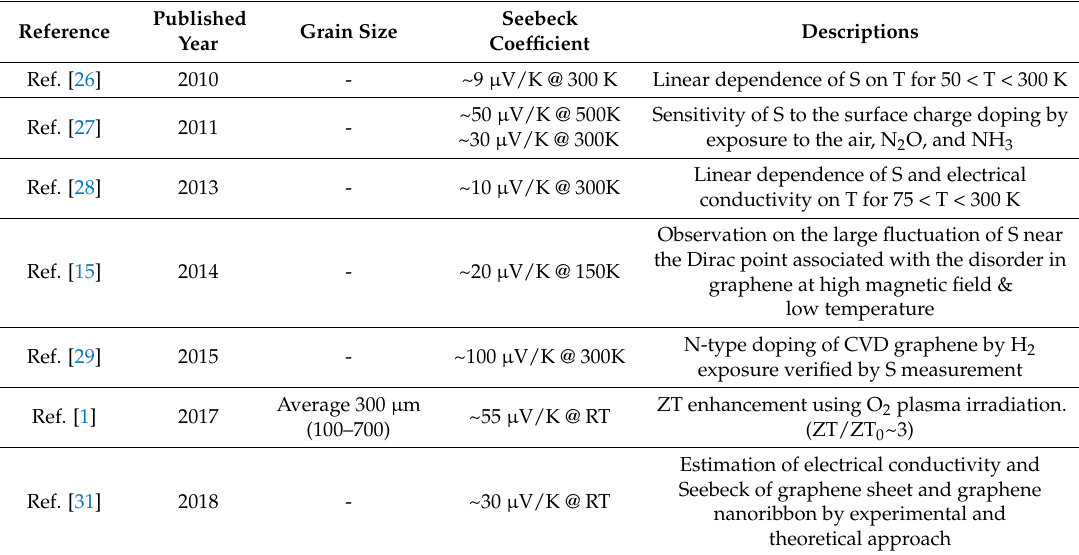
Table 2. Published list of Seebeck coefficients of CVD